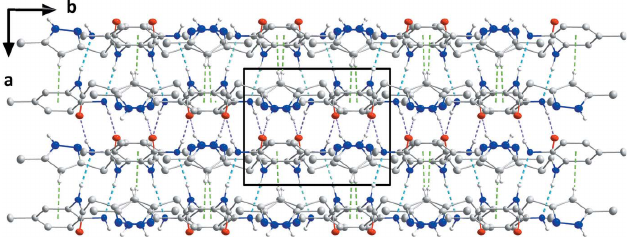
Figure 3 Packing arrangement viewed along the c -axis direction of the main isomer with intermolecular interactions shown as in Fig. 2.